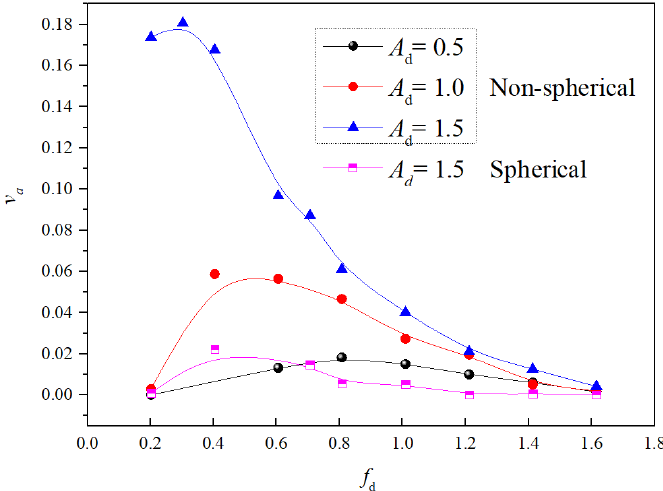
Figure 7. The influence of f d on v a for the spherical intruder ( d l = 6 mm) and the non-spherical in- truder ( d Sau = 6 mm, a / b = 3.0). intruder ( d Sau = 6 mm, a / b =